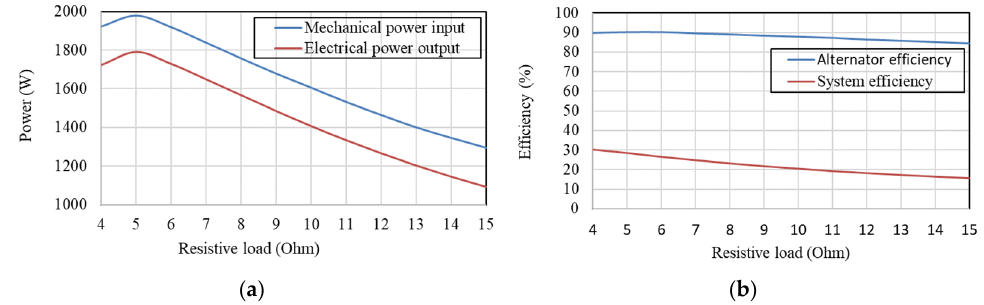
Figure 11. Mechanical power input and electrical powers output of long translator alternator versus resistive load. ( a ) Mechanical power input and electrical powers output of Model ‘A’ generator versus resistive load. ( b ) Model ‘A’ generator and system efficiencies versus resistive load.